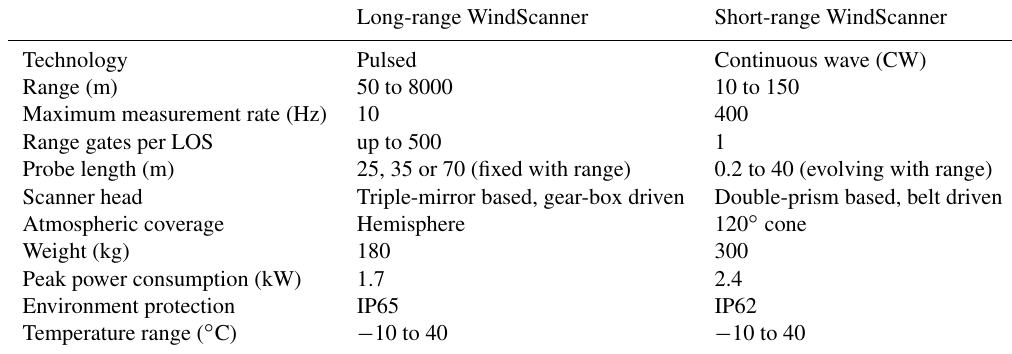
Table 1. Characteristics overview of the